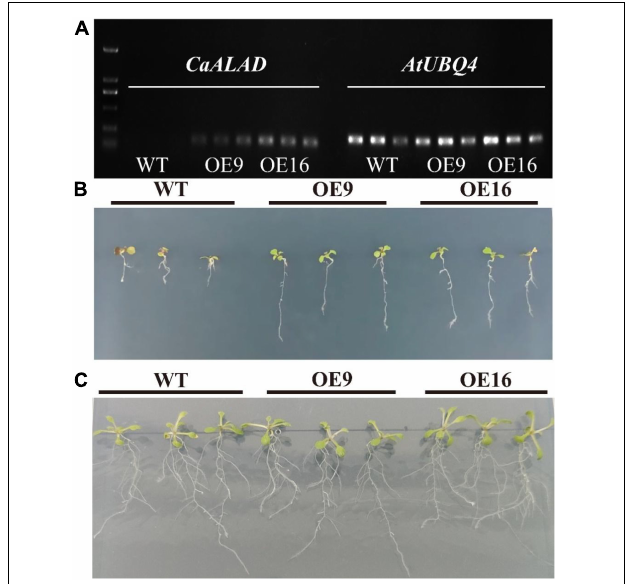
FIGURE 3 | Effects of the overexpression of CaALAD on growth in transgenic Arabidopsis Col-0 plants exposed to low temperature stress for 1 week. WT: wild-type Arabidopsis thaliana Col-0. OE: the CaALAD -overexpressing (OE) lines. (A) Electrophoresis results of CaALAD in A. thaliana by semi-quantitative PCR. (B) The phenotypes of WT and OE plants that were exposed to low temperature stress at 4 ◦ C for 1 week. (C) The phenotypes of WT and OE plants grown at 23 ◦ C for 1